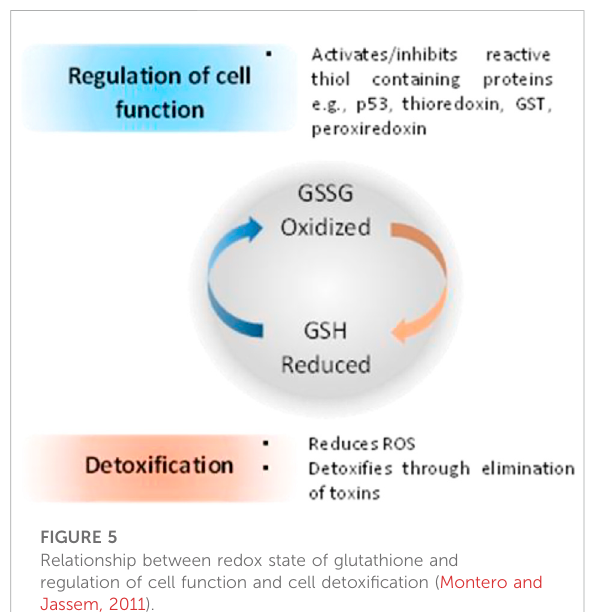
FIGURE 4 Relationship between metabolism and redox signaling in cancer cells (Wang et al., 2019).